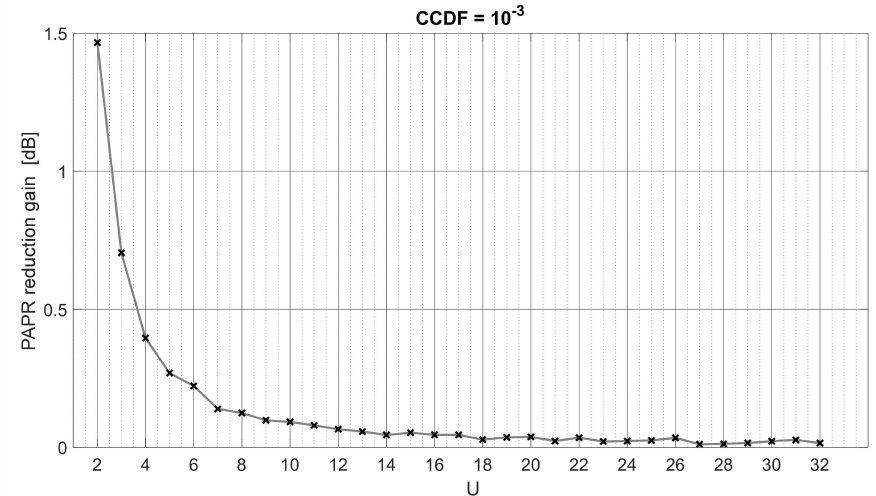
Figure 5. Marginal improvement of PAPR reduction gain of the random SLM method with the increase of number U with CCDF = 10 − 3 .